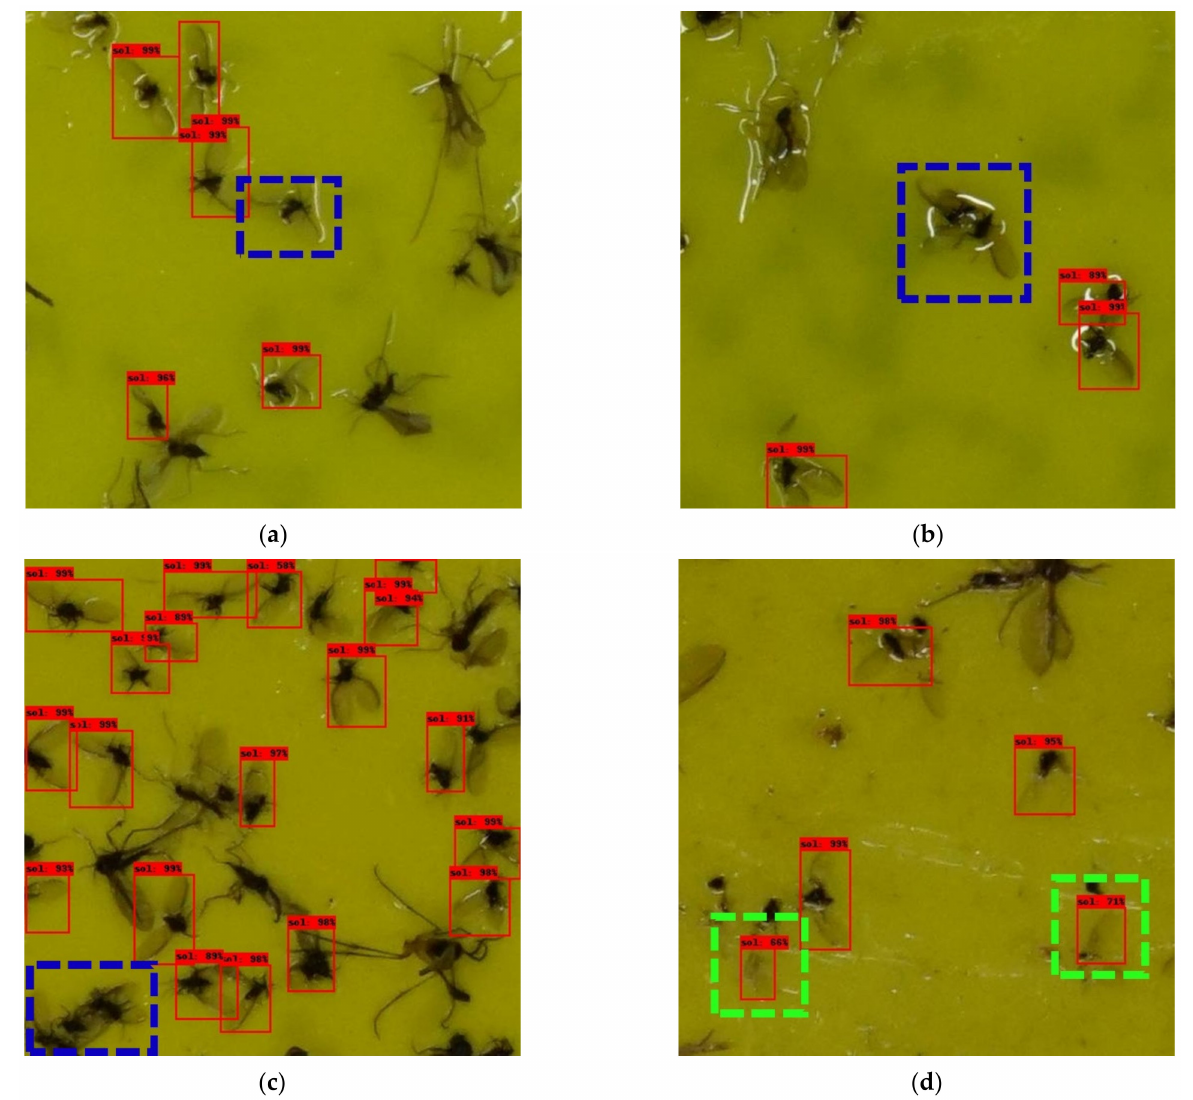
Figure 9. Detection errors: ( a – c ) false negatives; ( d ) false positives.